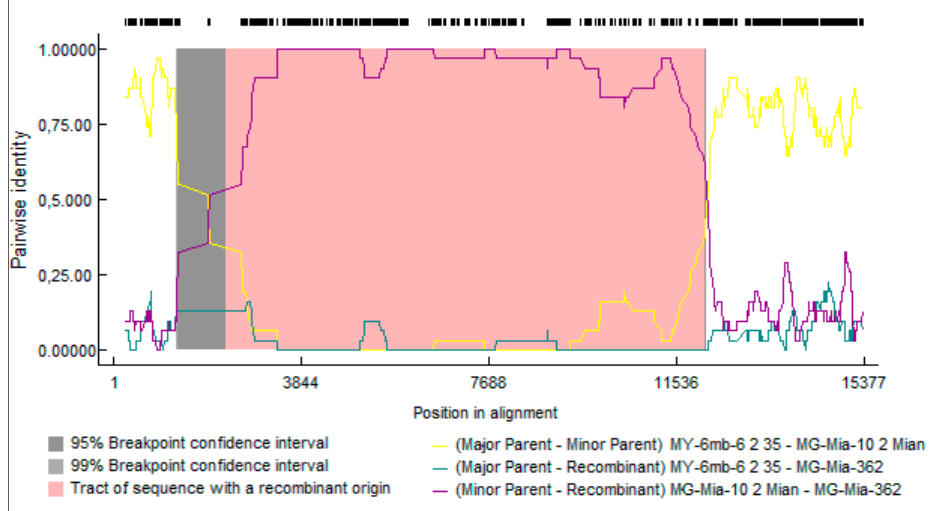
Figure 5. Recombination event detected among isolates from MeaV-2 by the RDP4 program.